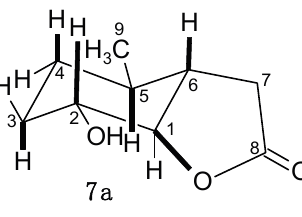
Figure 3. Structure of hydroxylactones 7a